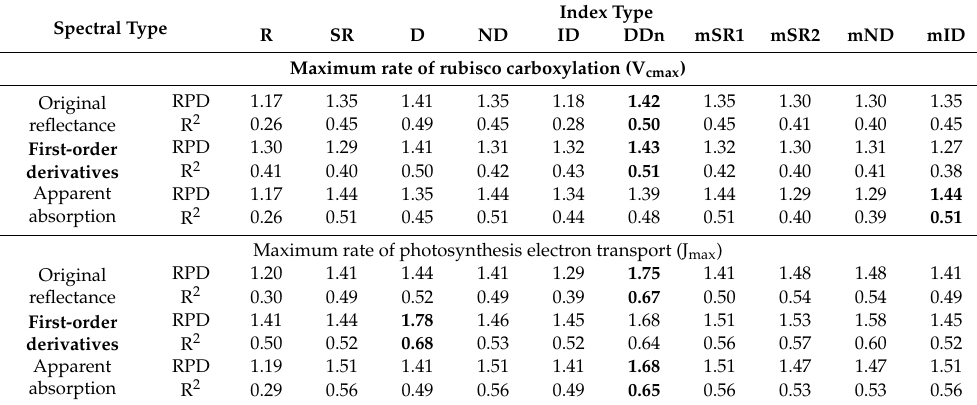
Table 5. RPD and coe ffi cient of determination based on di ff erent spectral